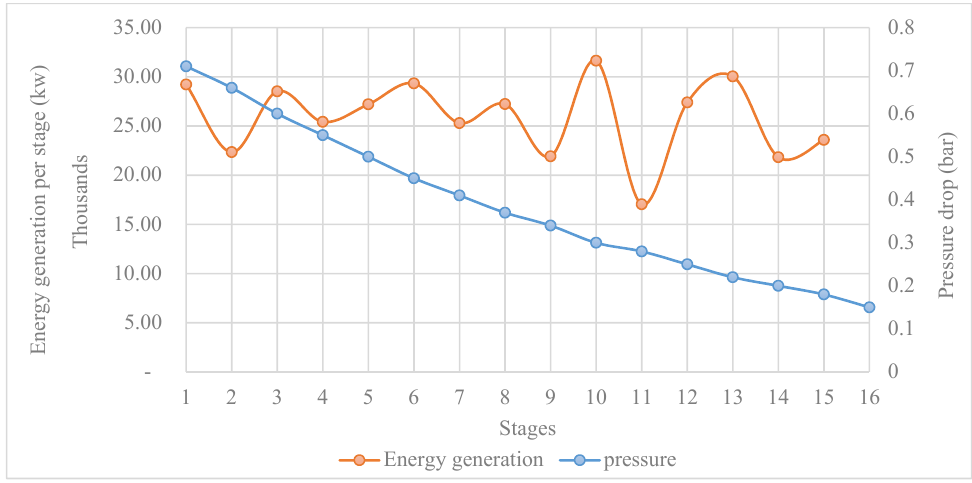
Figure 14. Variation in energy released per stage as a function of the pressure drop. Table 4. Brine stream properties before and after stage 2, with 10 kg/s flash steam assumed.